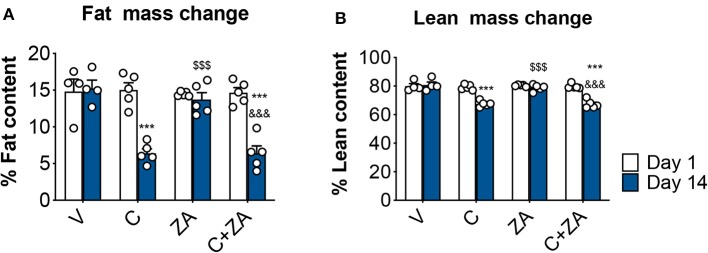
Fat and lean content in chemotherapy-treated mice is not protected by ZA administration. Fat (A) and lean (B) mass on day 1 and day 14 were assessed in mice exposed to C and/or ZA (n = 4–5) by using EchoMRI. Data (means ± SEM) are expressed as percentage of body mass. Significance of the differences: ***p < 0.001 vs. V; $$$p < 0.001 vs. C; &&&p < 0.001 vs. ZA (at the respective time point).